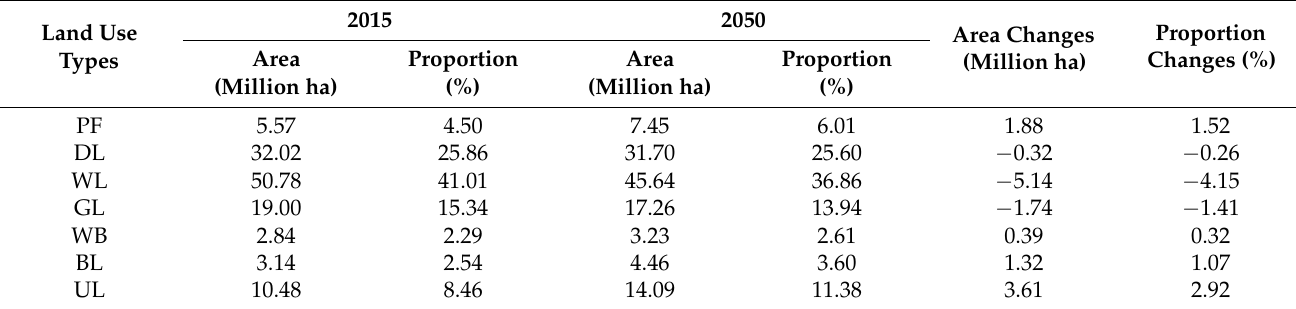
Table 4. Area and proportion changes of land-use types from 2015 to